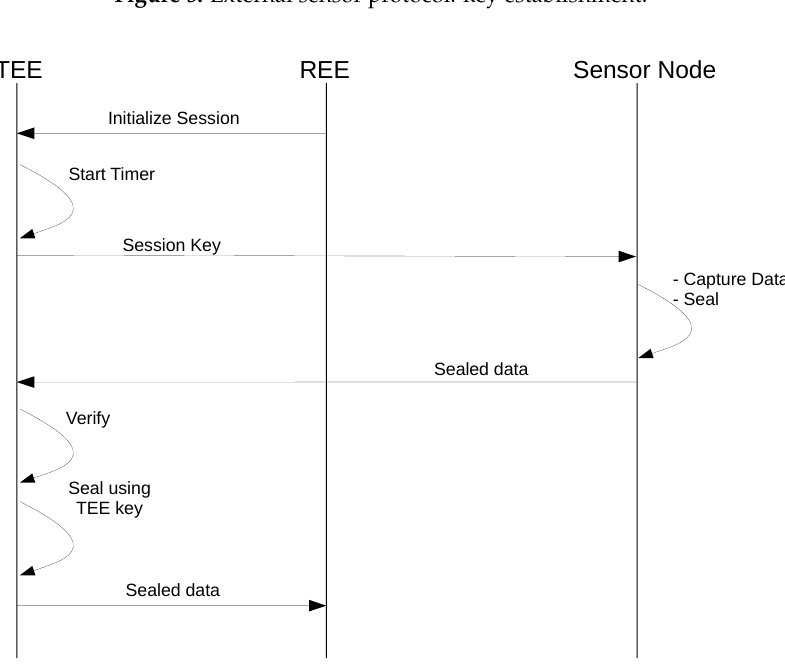
Figure 6. External sensor protocol: data